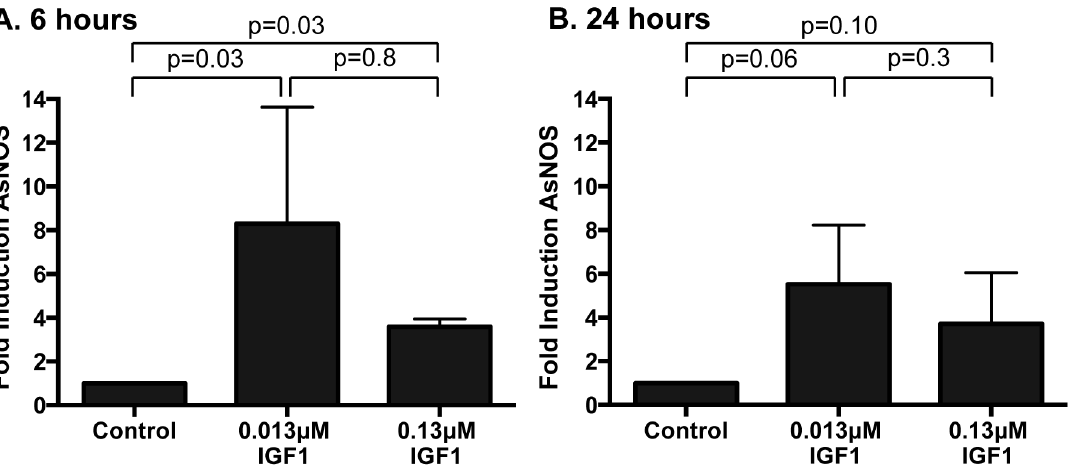
Figure 4. Ingested human IGF1 increased NOS gene expression in A.stephensi midguts. Mosquitoes were fed artificial blood meals supplemented with 0.013 or 0.13 m M IGF1 or with an equivalent volume of PBS as a control. Midguts were dissected at (A) 6 h and (B) 24 h after feeding and RNA was isolated for quantitative RT-PCR. Data are represented as fold change in NOS gene expression relative to PBS control. Experiments were replicated 4–6 times with separate cohorts of mosquitoes and p-values are indicated. Normally distributed data were analyzed by unpaired t-test (24 h), and non-normally distributed (6 h) data were analyzed by Mann Whitney test.